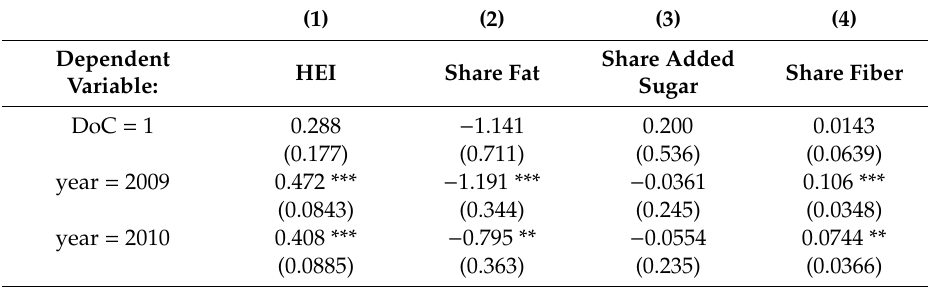
Table A8. Test of common trend of NL switchers, DoC switchers, Both switchers and